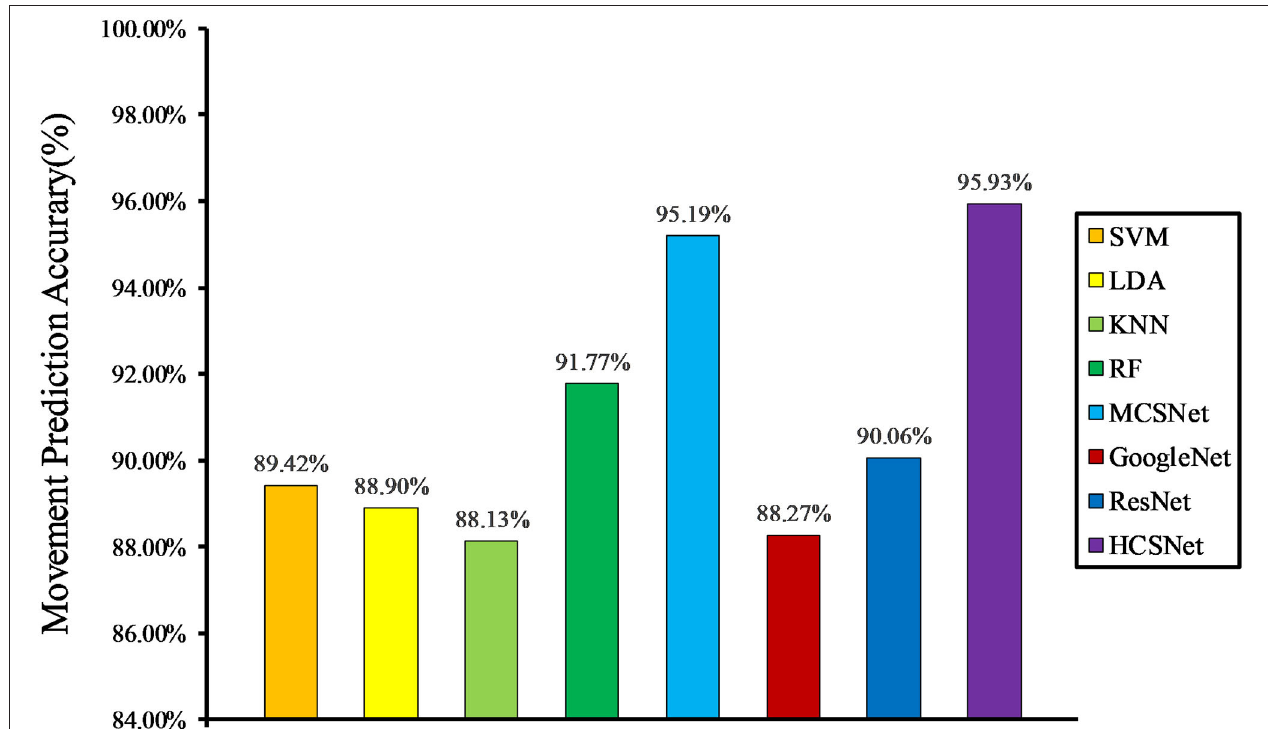
FIGURE 5 | Within-subject movement prediction performance, 4-fold cross-validation is used to avoid the phenomenon of model overfitting averaged over all folds and all subjects.